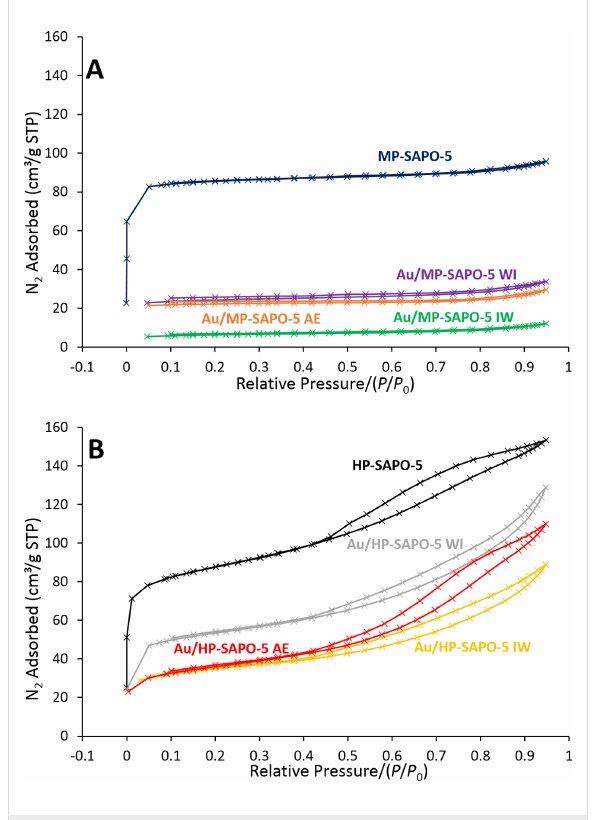
Figure 2: Nitrogen physisorption isotherms of gold-deposited microp- orous (A) and hierarchical (B) SAPO-5 systems showing that porosity is maintained in hierarchical HP-SAPO-5, but not in microporous